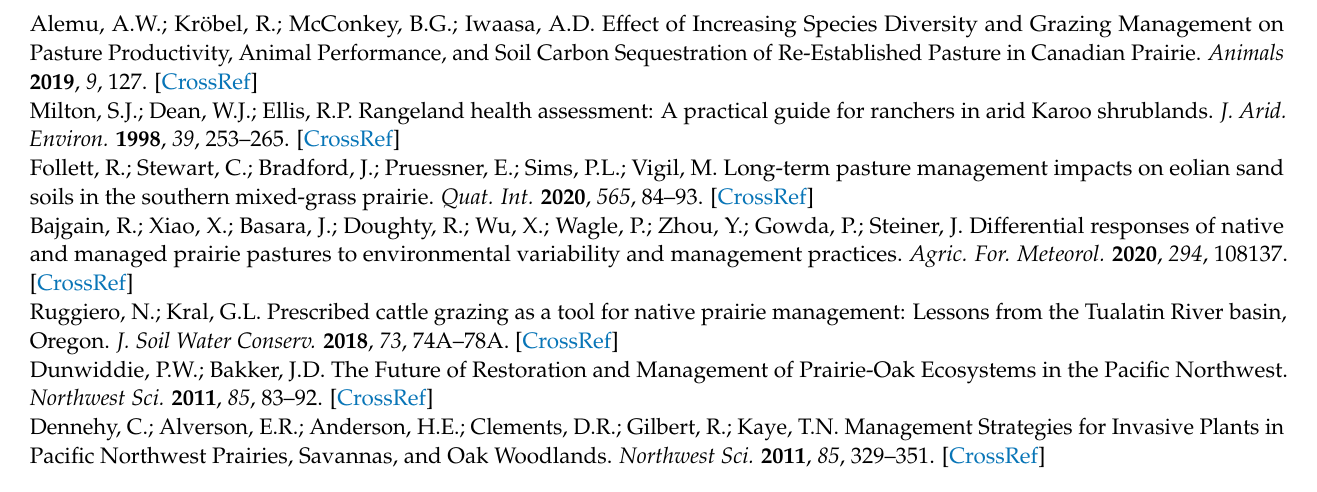
Figure S2: NIR reflectance of upland, sloped, and valley grasslands from both GNP and the sur- rounding pastures; Figure S3: SWIR1 reflectance of upland, sloped, and valley grasslands from both GNP and the surrounding pastures; Figure S4: SWIR2 reflectance of upland, sloped, and valley grasslands from both GNP and the surrounding pastures; Figure S5: LST of upland, sloped, and valley grasslands from both GNP and the surrounding